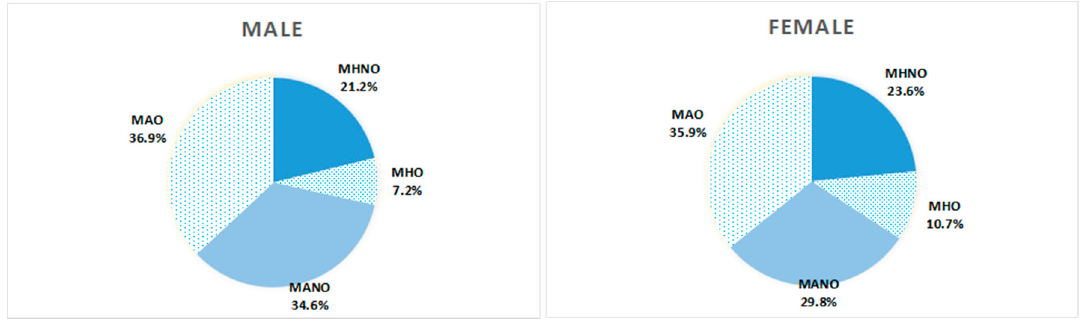
Figure 2. Prevalence of different obese phenotypes among rural Chinese resident by different genders.